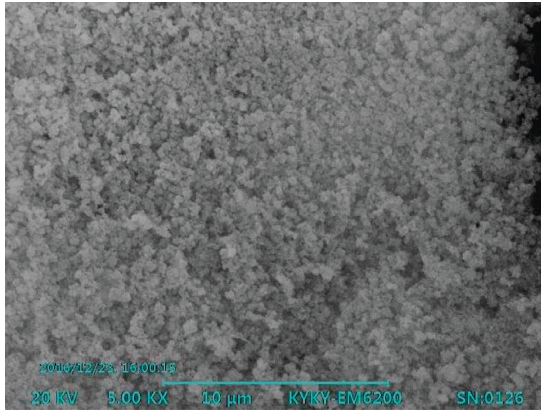
Figure 7: Silica fume